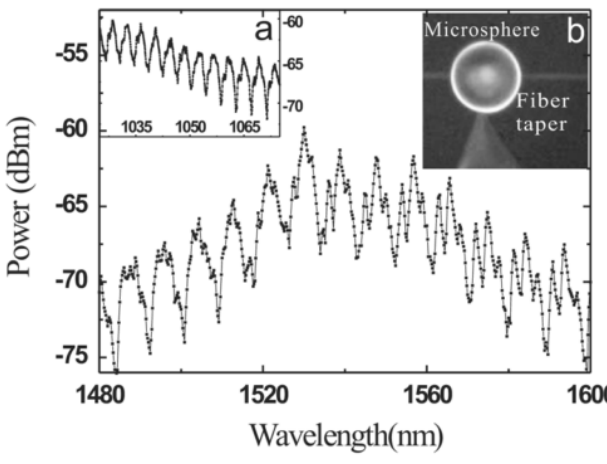
Figure 9. ( a ) The spectrum in the band of 1040 nm; ( b ) the image of the microsphere and tapered fiber; ( c ) Fluorescence spectra of Er ions doped microsphere. Reprinted/Adapted with permission from [31]. The relationship between the laser output power of the Er 3+ ‐ Yb 3+ doped microsphere and the absorbed power was obtained by increasing the pump power continuously in a range beyond the laser threshold. As shown in Figure 10, the laser threshold at a wavelength of 1032 nm and 1563 nm are 32 μ W and 30 μ W, respectively.